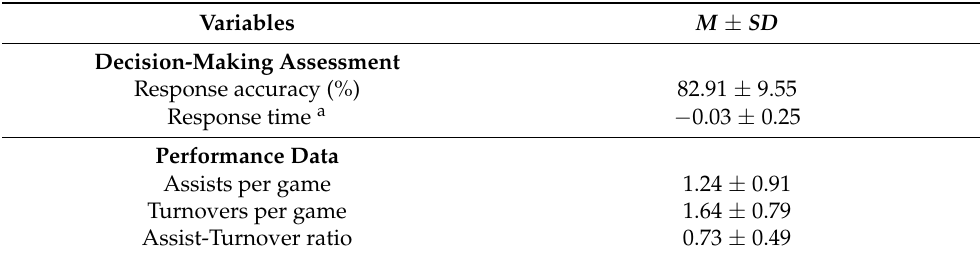
Table 3. Descriptive statistics for the diagnostic results and the performance data serving as predictor and external criterion variables in the multiple regression